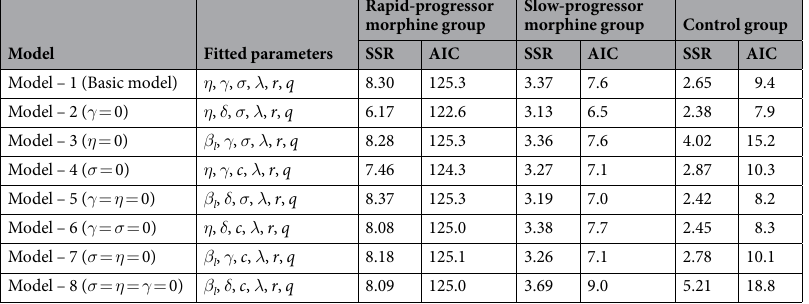
Table 2. Fitted parameters, calculated Akaike’s Information Criterion (AIC) and Sum of Squared Residuals (SSR) for model fits to median data for each